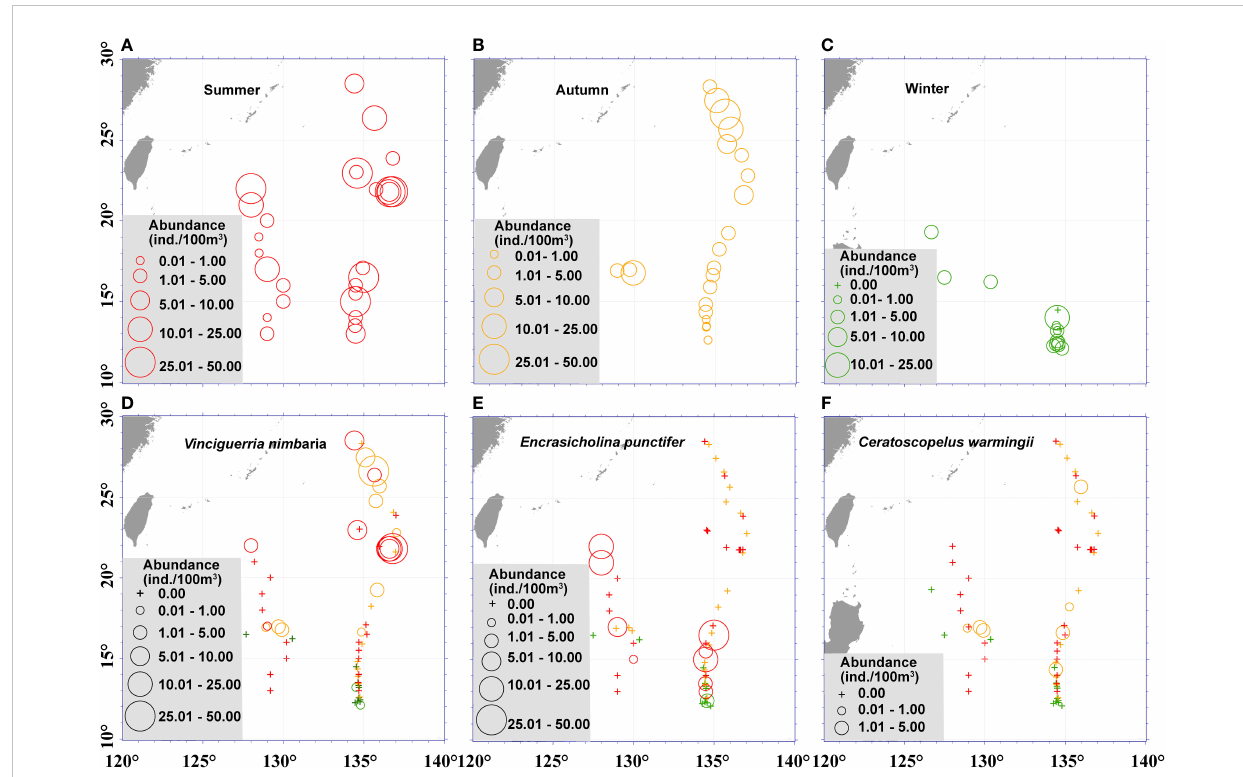
FIGURE 4 Seasonal and spatial variations of fi sh larvae assemblages in the Philippine Sea. The fi sh larvae abundance during the 3 seasons ( A , summer; B , autumn; C , winter), and abundance of dominant species Vincigueriia nimbaria (D) , Encasicholina punctifer (E) , and Ceratoscopelus warmingii (F) in the Philippine Sea, stations sampled in summer are shown in red, stations sampled in autumn are shown in orange, and stations sampled in winter are shown in